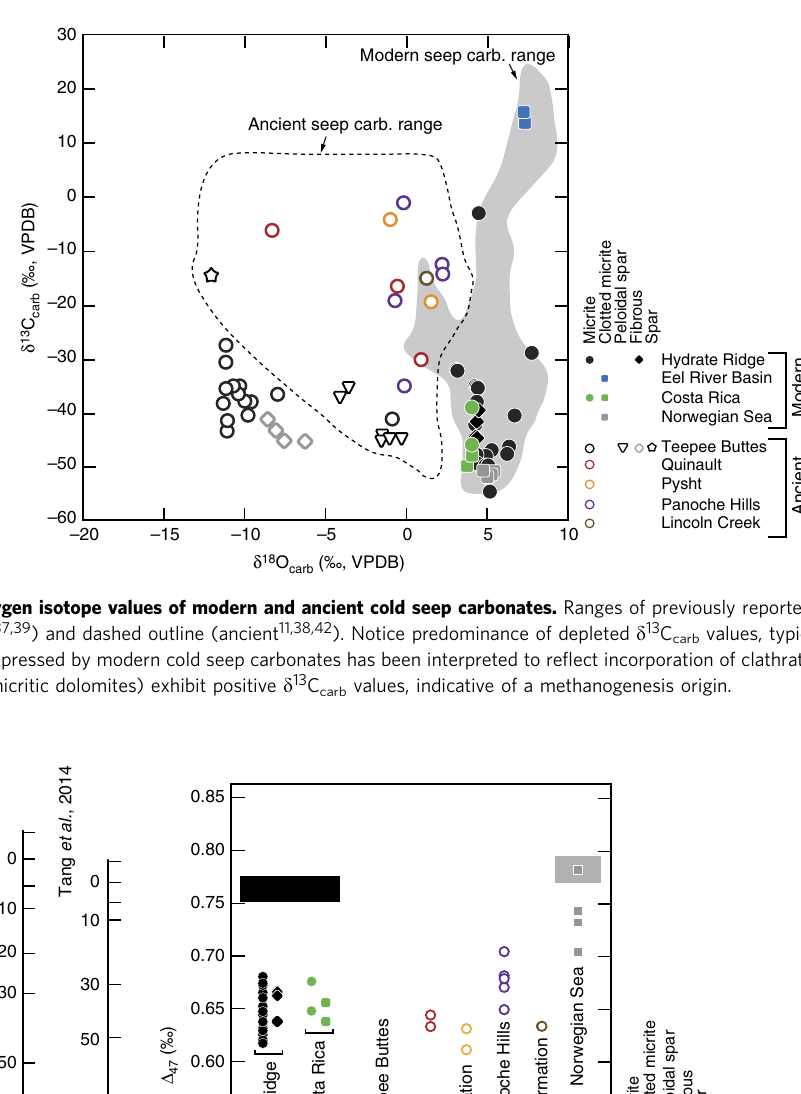
NATURE COMMUNICATIONS|7:12274|DOI: